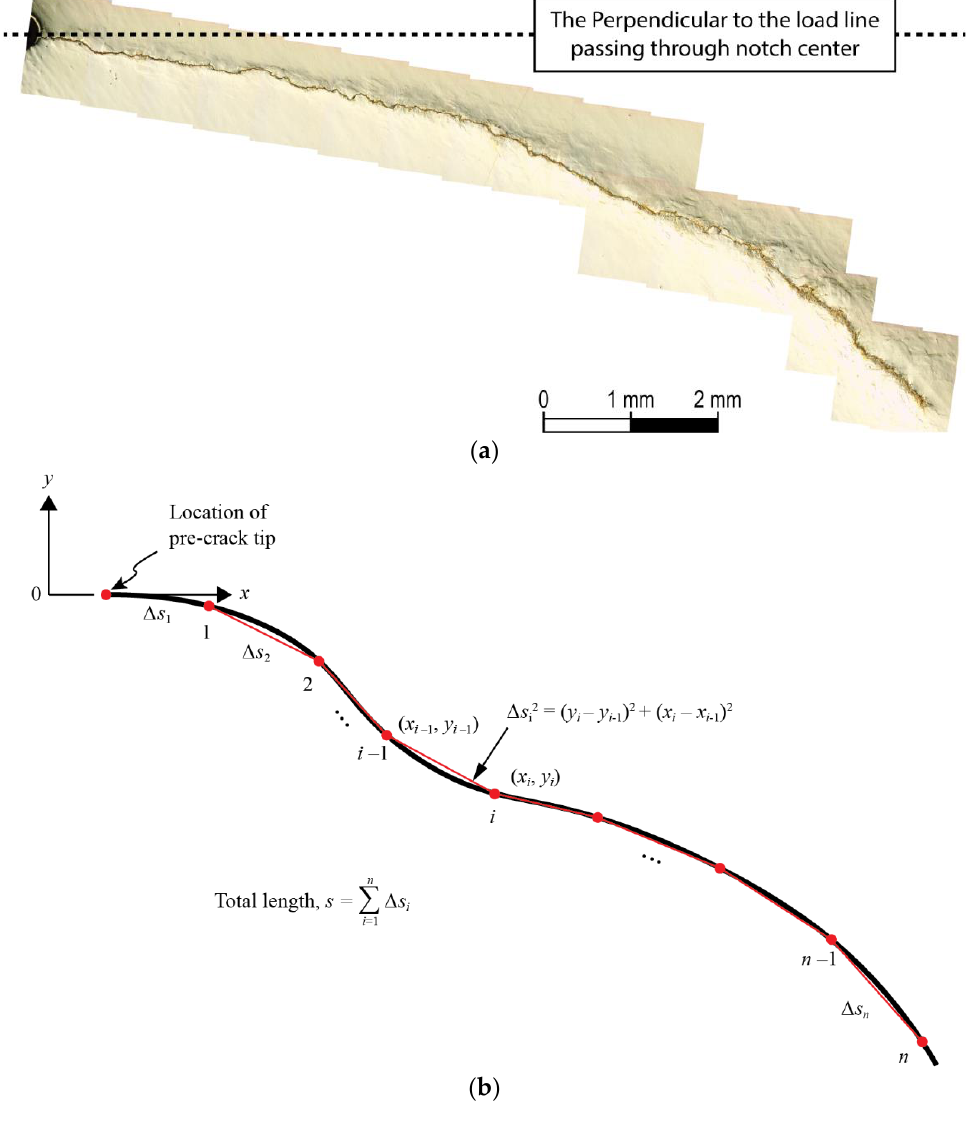
Figure 3. ( a ) Composite image of the fatigue crack in the bell crank structure and ( b ) calculation methodology of the crack length along the curved crack path.